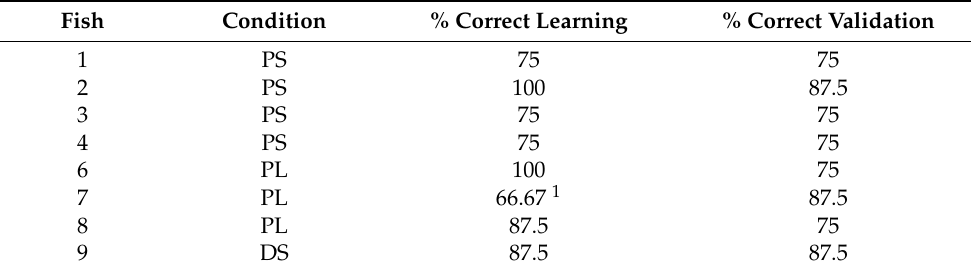
Table 1. First choices (%) in both the learning and validation sessions. Fish